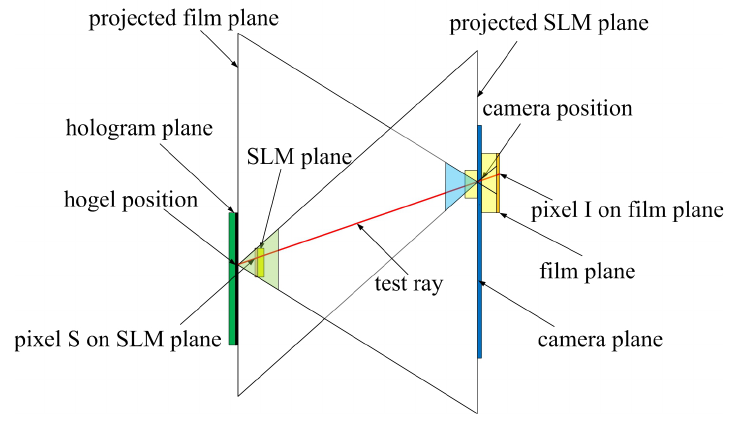
Figure 1. Ray-tracing principle of “I to S” transformation by DWDH